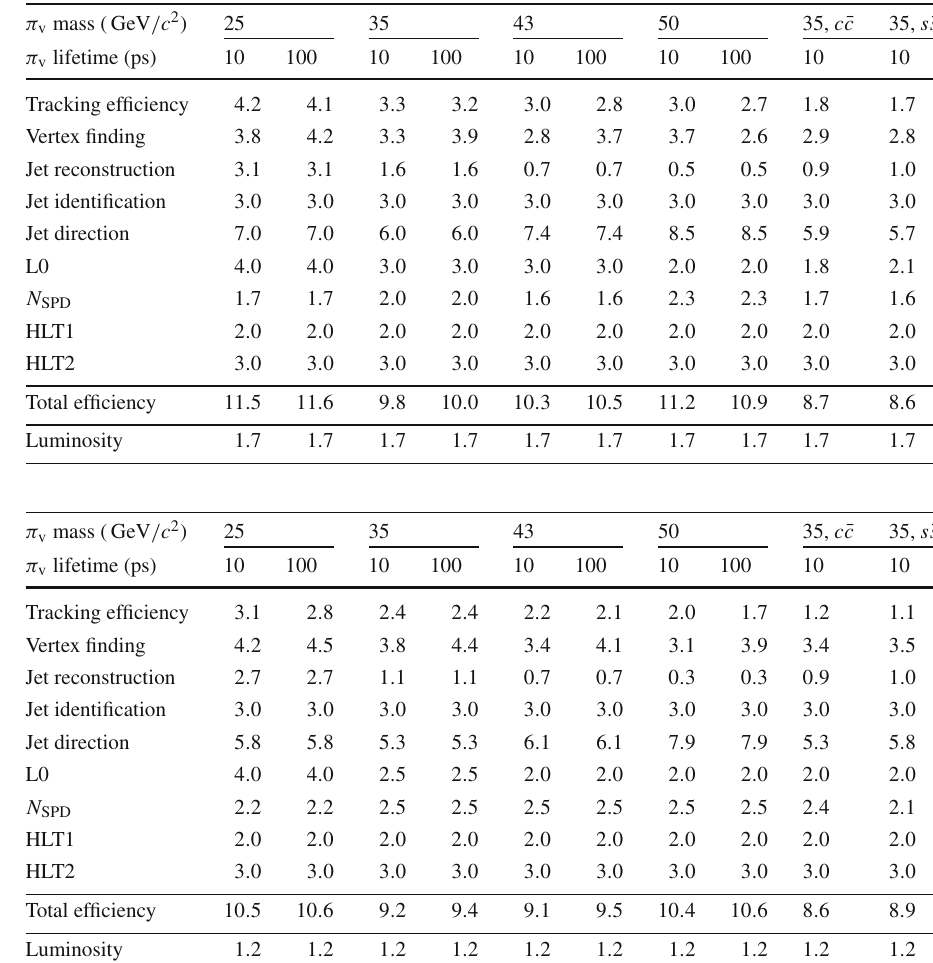
contributions to the relative systematic uncertainty on the signal efficiency and luminosity (in percent) for different signal samples in 2011 conditions. The uncertainty on the total efficiency is obtained by summing the individual contributions in quadrature